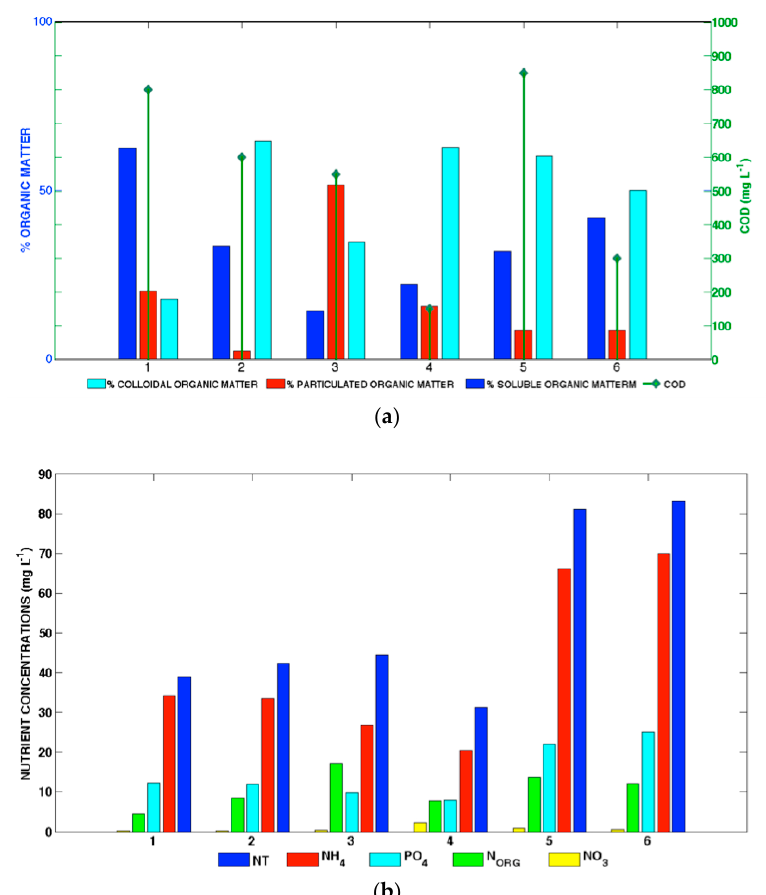
Figure 4. Mean values of organic matter and nutrient concentrations of the six patterns used to characterize the 150 influent samples treated by the prototypes. ( a ) COD (colloidal, particulate and soluble organic matter percentages). ( b ) Nitrogen forms and Total Phosphorous.